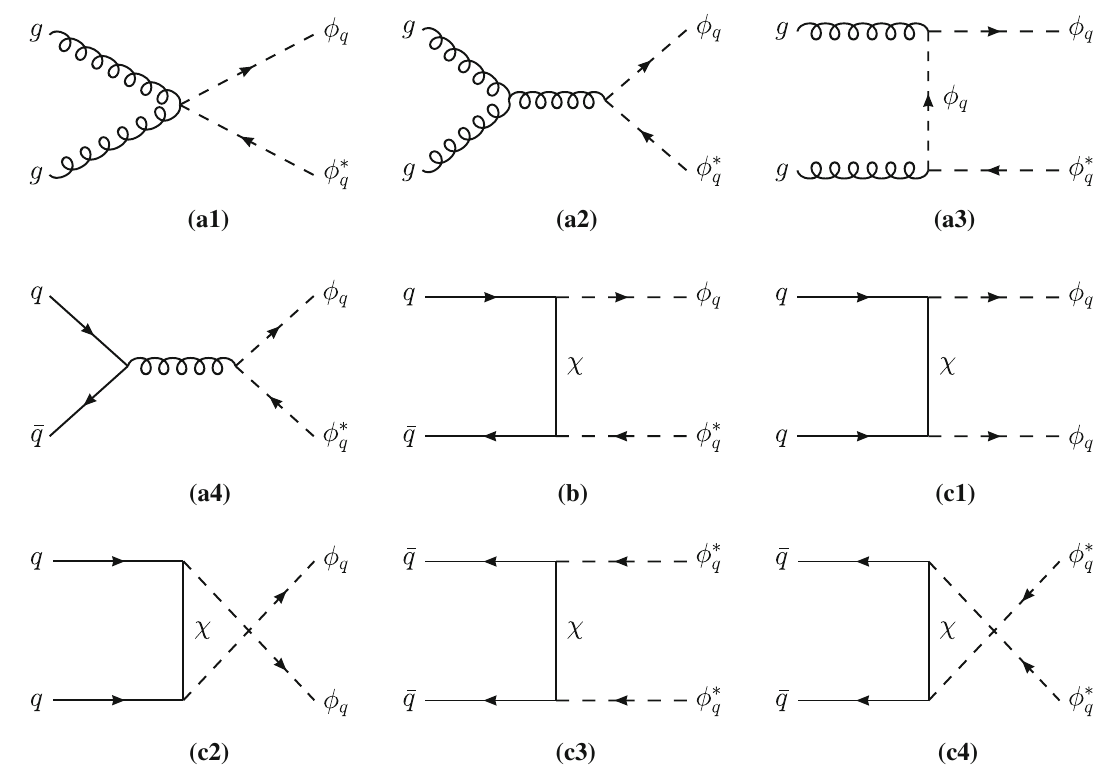
Fig. 4 Diagrams for the pair production of the coloured scalar mediator, φ q , leading to dijet + E T / signatures in the final state. Diagrams (a1)–(a4) are generated by purely QCD interactions, and diagrams (b), (c1)–(c4) are generated by DM t-channel